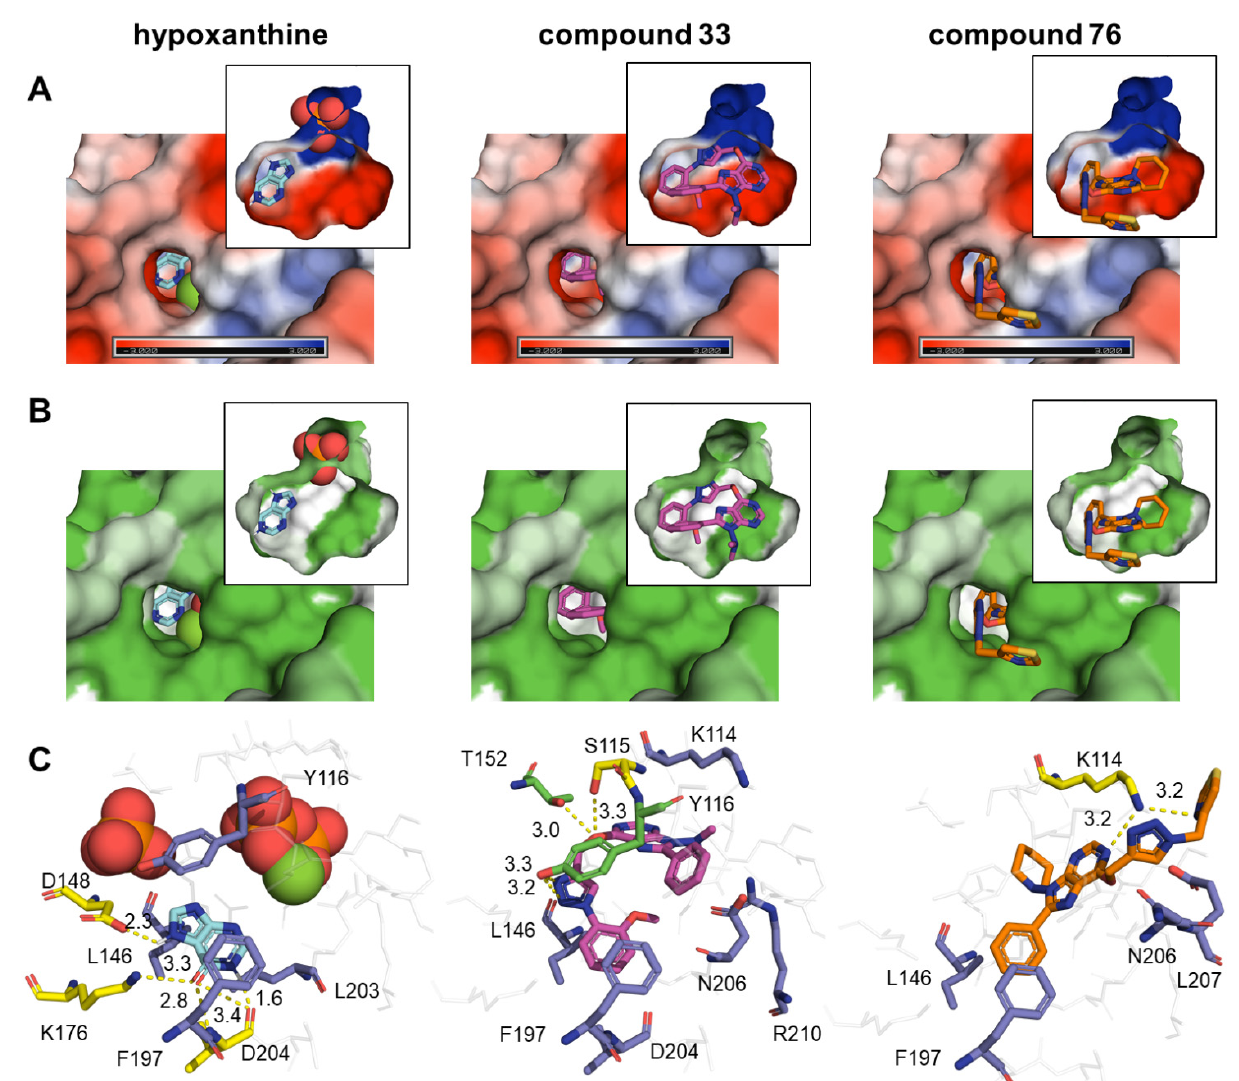
Figure 7. Binding of natural ligand and hit compounds with Pf HGXPRT. ( A ) Electrostatic surface view of the binding pocket of Pf HGXPRT. ( B ) Hydrophobicity surface view of the binding pocket of Pf HGXPRT. ( C ) Zoomed-in view of the interactions between Pf HGXPRT active site residues and their corresponding natural ligands or hit compounds. In panel C, residues that form hydrophobic interactions at a maximum distance of 3.9 Å are shown as purple sticks, those that formed H bonds as yellow sticks, and those involved in both types of interactions as green sticks, while non-interacting residues are represented as grey sticks. Expected H bonds are represented in yellow. In panel B, the hydrophobicity surface map was generated using the Kyte–Doolittle hydrophobicity scale. Red and orange spheres represent a pyrophosphate and a phosphate group, whereas the green sphere is a magnesium group.